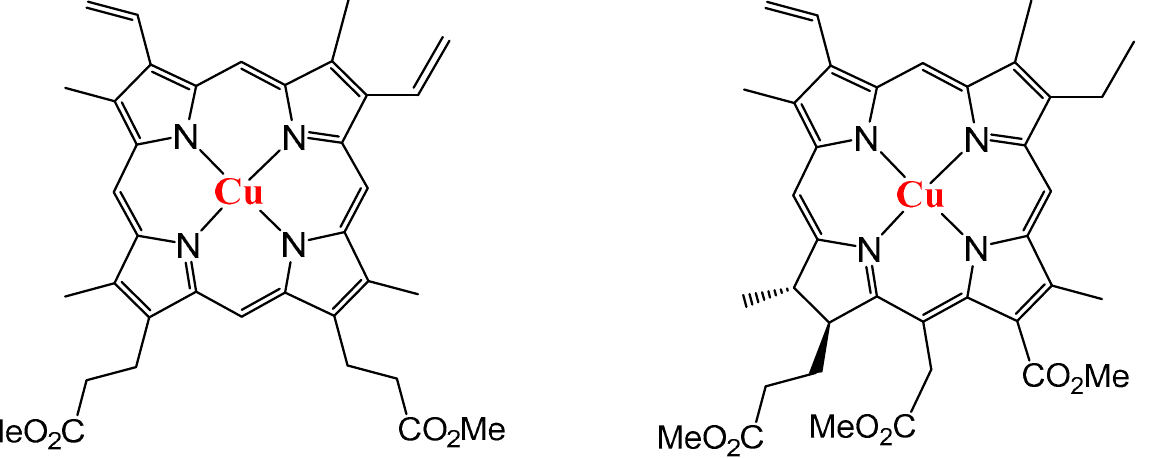
Figure 1. The structure of Cu (II) protoporphyrin Cu ‐ PP ‐ IX ( left ) and chlorin Cu ‐ C ‐ e6 ( right ).